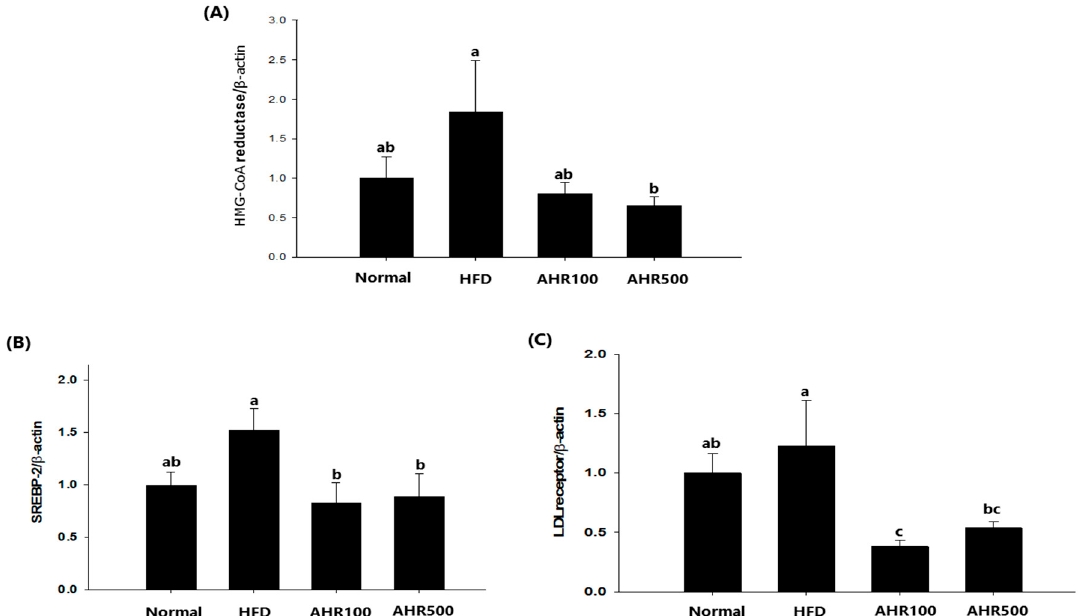
Figure 5. Effects of AHR on hepatic mRNA levels of HMG-CoA reductase ( A ), SREBP-2 ( B ), and LDL receptor ( C ) in HFD-induced obese mice. mRNA expression level was determined by real-time RT-PCR quantification and normalized to that of mRNA β -actin. Data are expressed as mean ± SEM ( n = 6–8). Values with different letters are significantly different at p < 0.05.